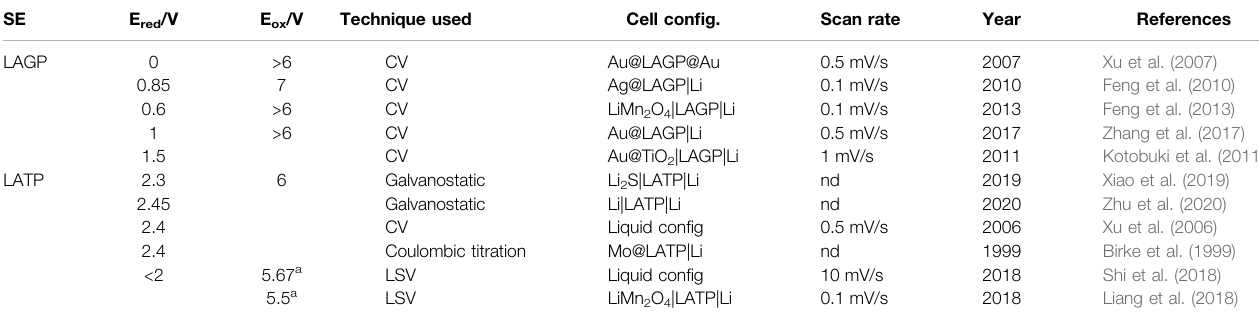
TABLE 1 | Electrochemical stability windows for LAGP and LATP SEs reported in the literature. SE E red /V E ox /V Technique